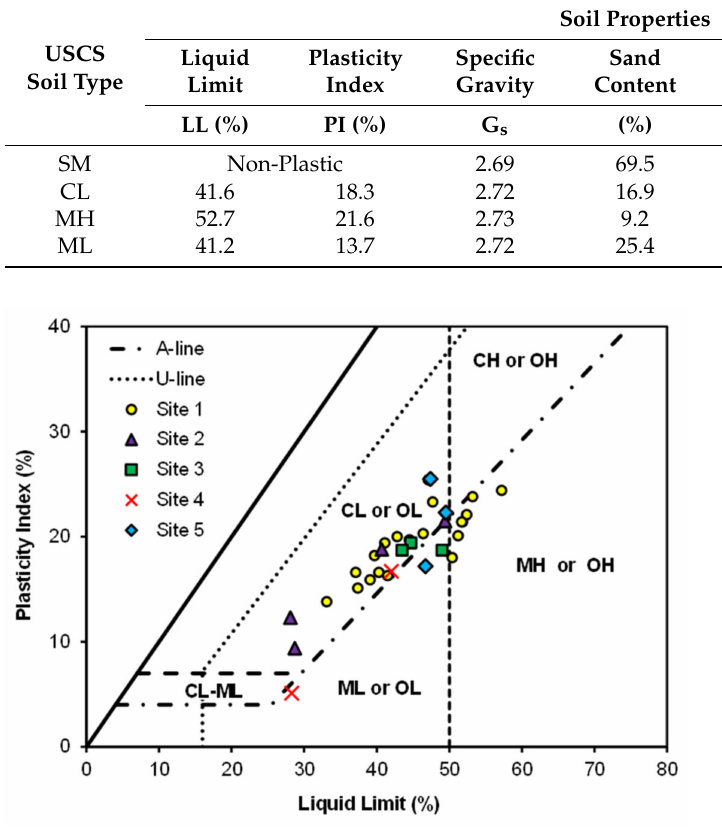
Figure 2. Atterberg limits of soils from the test sites (C: clay, M: silt, O: organic soil, H: high plasticity, and L: low